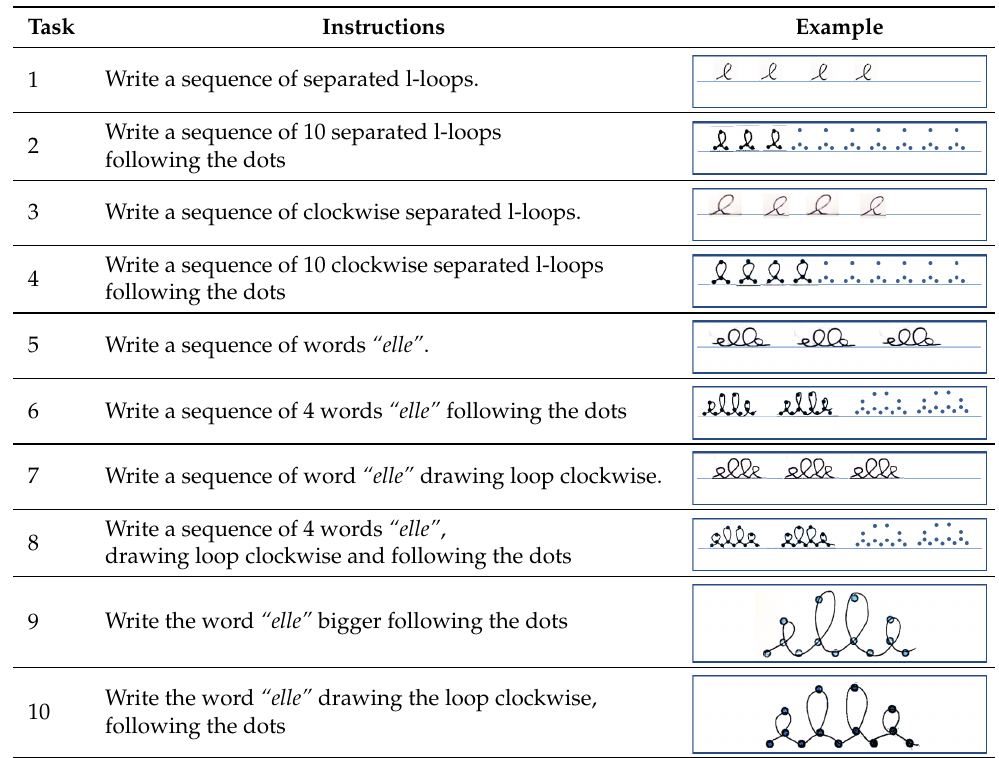
Table 2. Handwriting tasks: the first column lists the task number, the second column reports the instructions provided to the participant by the experimenter, and the third column shows an example of the performed